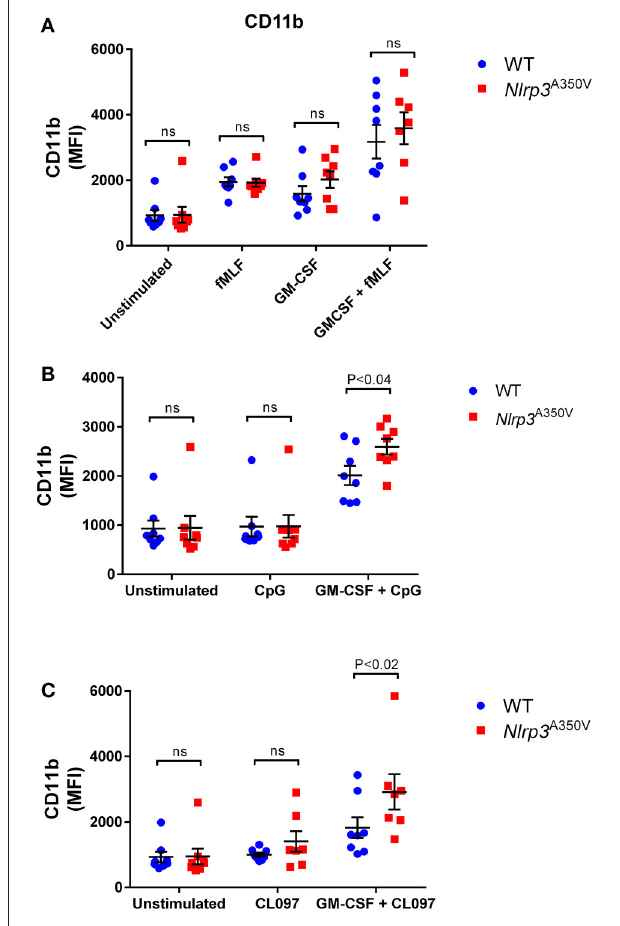
FIGURE 1 | Effect of the Nlrp3 A350V mutation on secretory vesicle exocytosis in neutrophils. (A–C) , The mobilization of secretory vesicles was analyzed by monitoring the upregulation of the neutrophil adhesion molecule CD11b at the plasma membrane by flow cytometry using specific antibodies that detect extracellular epitopes of the indicated marker. Wild type (WT: blue) or MWS neutrophils (Nlrp3 mutant: red) were treated with GM-CSF or vehicle for 30min and subsequently stimulated with the indicated agonists as described under “Materials and Methods.” Each symbol corresponds to an individual mouse and the error bars indicate mean ± SEM of 8 independent mice from 3 independent experiments. Significant differences between groups were calculated using ANOVA followed by Fisher’s post-hoc test. ns, not